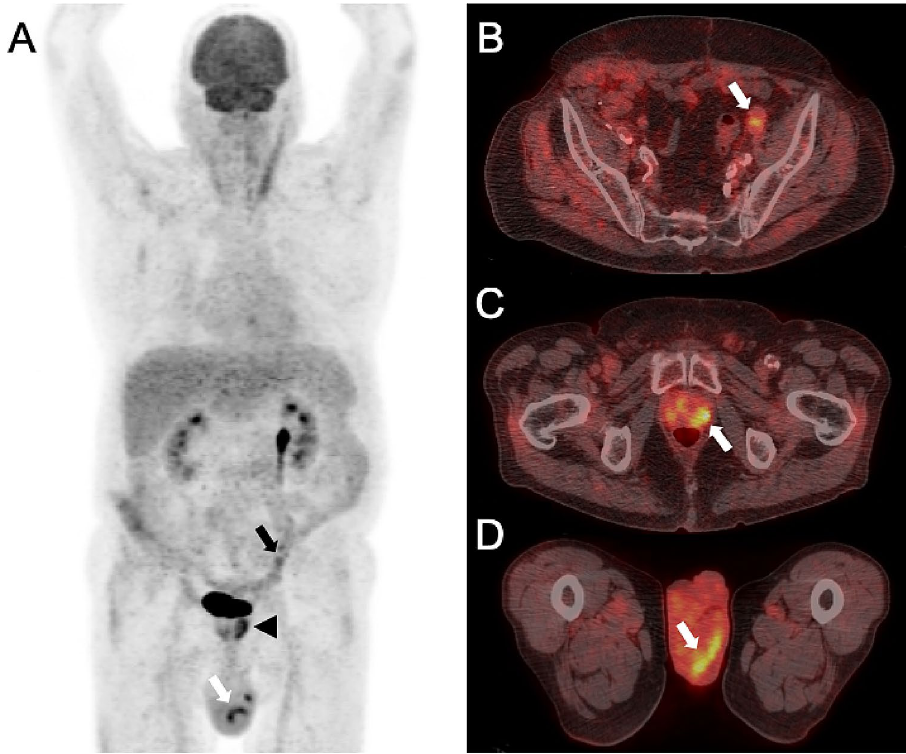
Figure 3. A 61-year old male patient was referred to PET/CT one year and four months after the initial diagnosis of a vascular endograft infection due to Streptococcus dysgalactiae . The patient was under antimicrobial therapy, but had acute fever and the reason for referral was the search for new infectious foci. PET/CT [maximum intensity reconstructions of PET ( A ) and fused PET/CT images ( B – D )] showed faint residual focal FDG uptake along the extraanatomical aorto bi-iliac reconstruction (Dacron silver Intergard graft) (black arrow in A, white arrow in B ), suggestive for persistent infection. Unknown and relevant incidental findings with impact on patient management were detected by PET/CT with intense focal FDG uptake in the prostate gland (black arrow head in A, white arrow in C ), and in the epididymis (white arrows in A and D ). Subsequent further work-up confirmed prostatitis with Enterobacter cloacae and antibiotic treatment was escalated